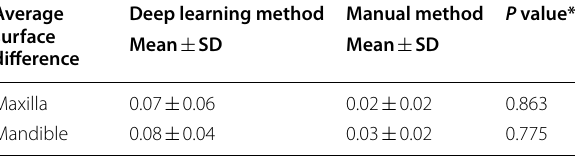
Data show the average surface discrepancy (mm) between the estimated and actual model in each deep learning and manual method by means of shell/shell deviation in the program. SD, Standard deviation.